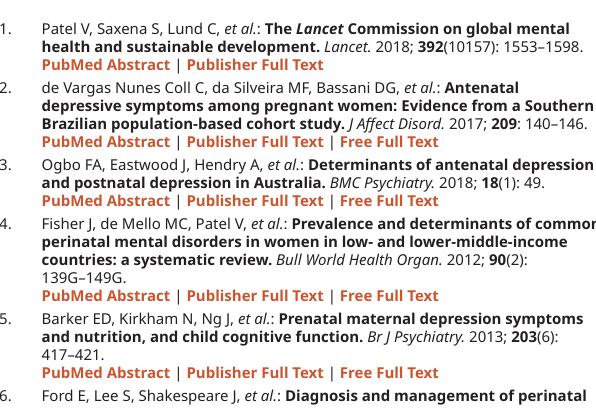
Extended data Figshare: Maternal Depression Experiences FDGs Interview guide, https://doi.org/10.6084/m9.figshare.13265420.v2 21 . Data are available under the terms of the Creative Commons Attribution 4.0 International license (CC-BY